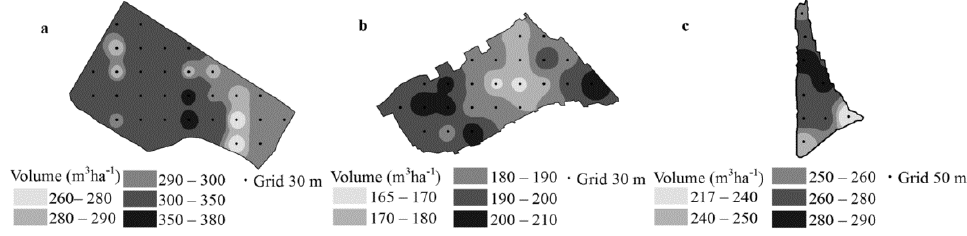
Figure 5. Inverse distance weighted (IDW) interpolation of volume data for stand 1 ( a ), stand 2 ( b ), and stand 3 ( c ).